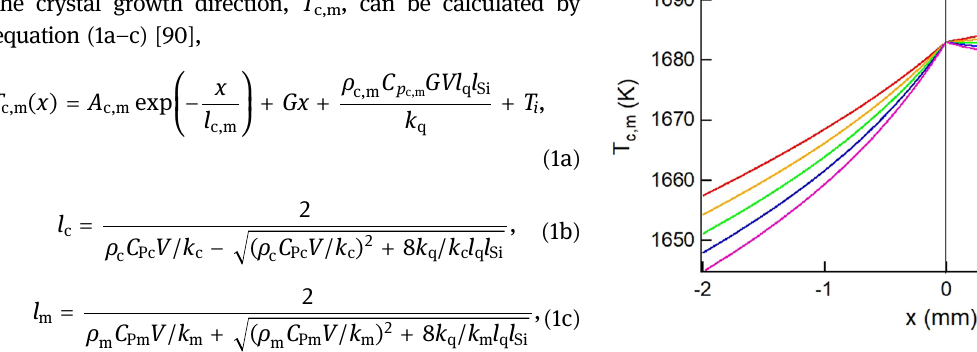
instability started at portions of the grain boundary in both cases, whereas the instability began over the entire inter - face at the same time in the case of single - crystal Si, as shown in Figure 7 ( b ) . The critical growth rate for initiation of instability at the grain boundary was found to be